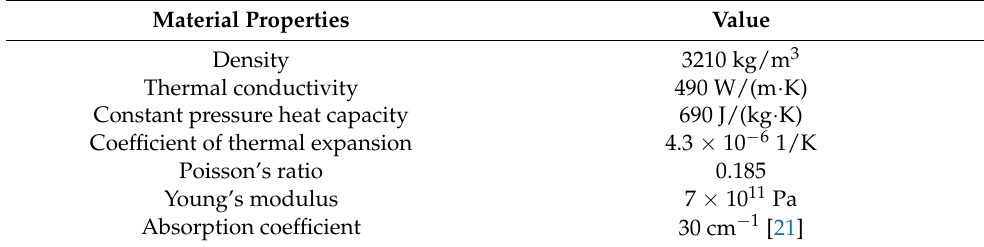
Table 2. Physical properties of